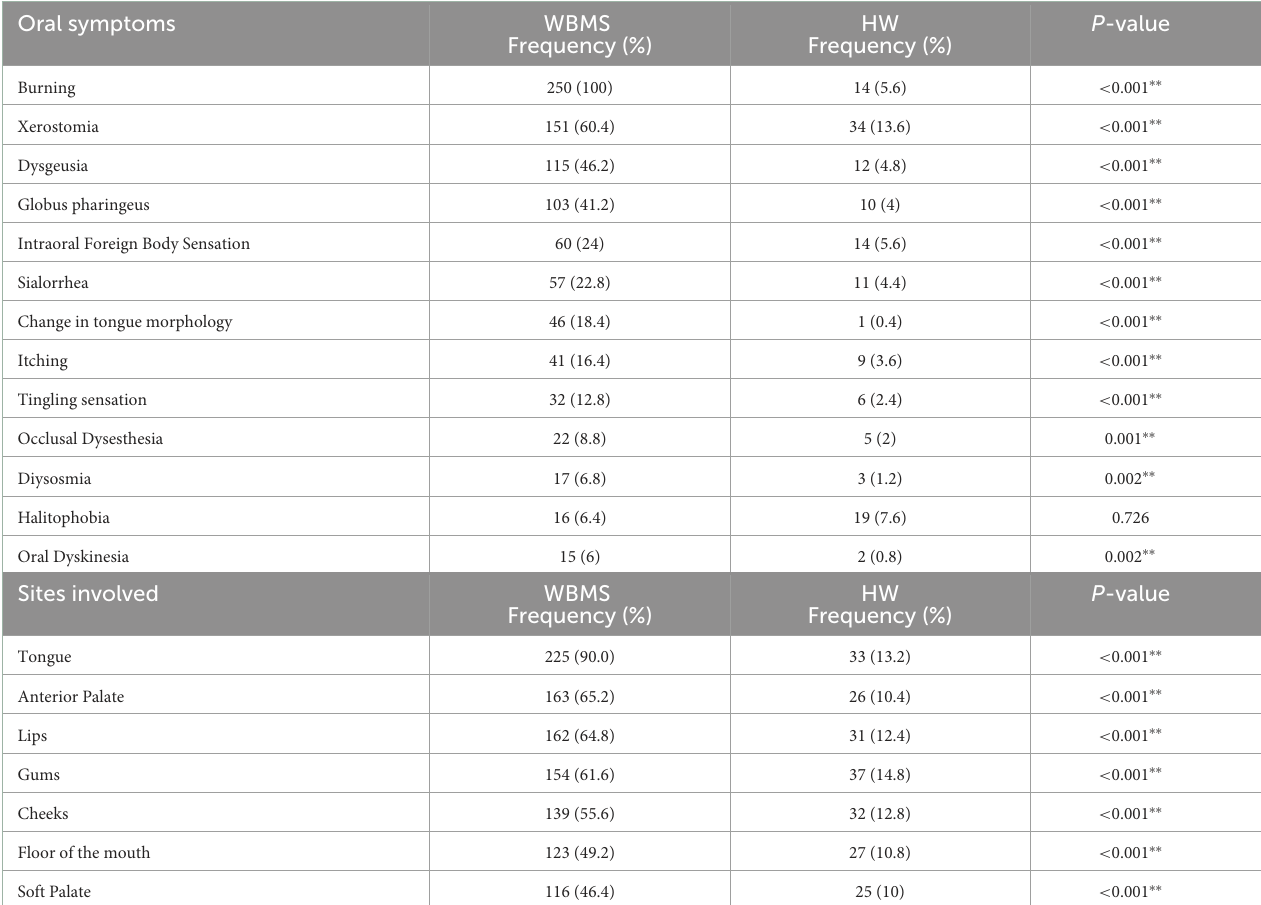
TABLE 3 Prevalence of oral symptoms and sites involved in 250 WBMS patients and 250 HW. Oral symptoms